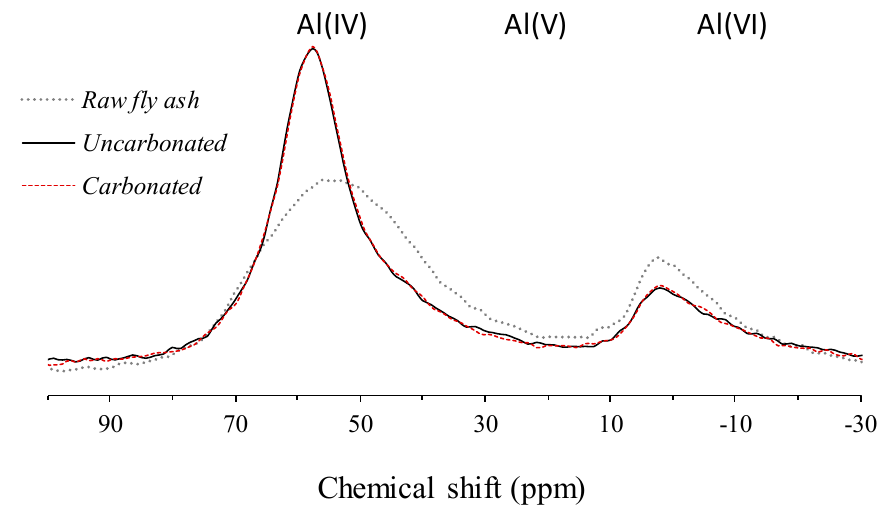
Figure 2. 27 Al MAS NMR spectra of raw fly ash and uncarbonated and carbonated alkali-activated fly ash.